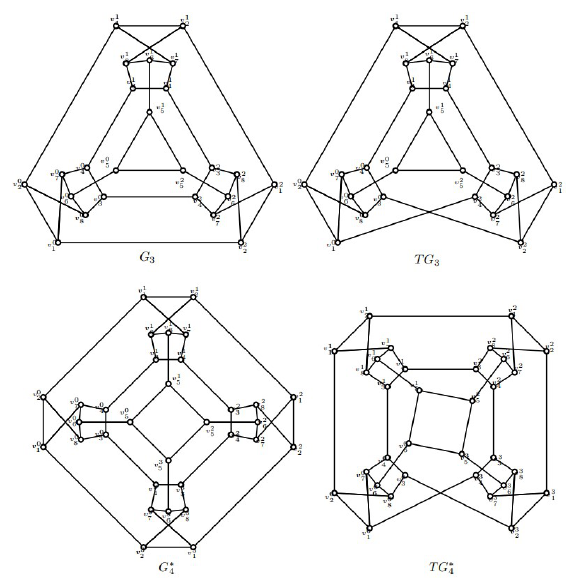
Figure 2. Graph G 3 , G 4 * , TG 3 and TG 4 *